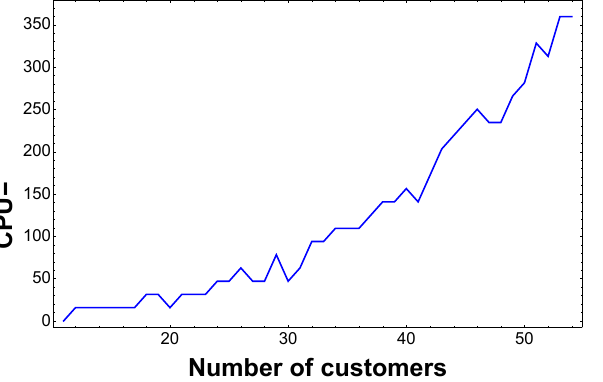
Figure 12. Performance of computing time for different amount of customers on the Puebla map.